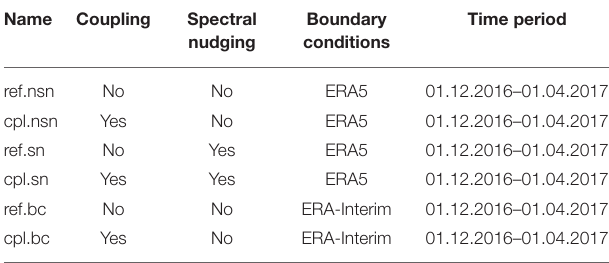
TABLE 1 | Experimental